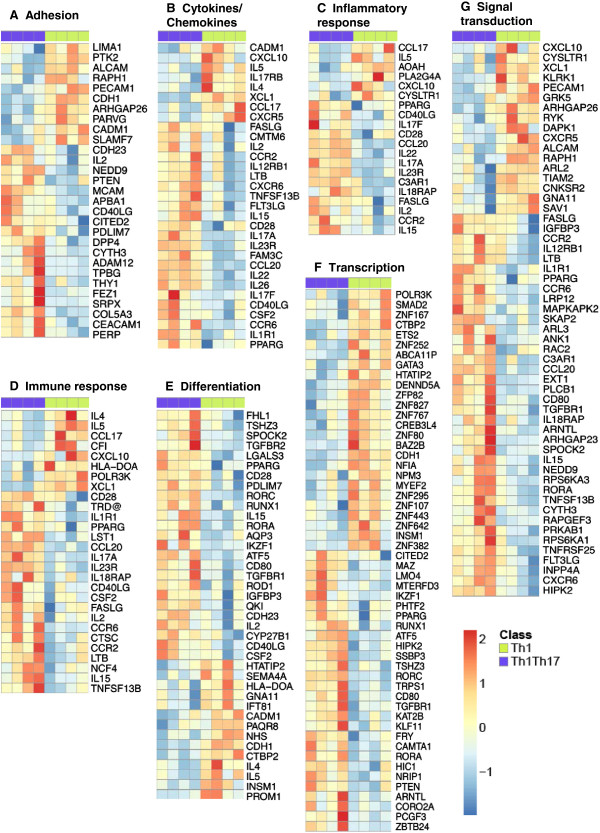
GO classification of differentially expressed genes in Th1Th17 vs. Th1 cells. Differentially expressed genes (p < 0.05, FC cut off 1.3) in Th1Th17 vs. Th1 were classified based on their biological functions using GO as follows: Adhesion (A), Cytokines/Chemokines (B), Inflammatory responses (C), Immune responses (D), Differentiation (E), Transcription (F), and Signal transduction (G). The corresponding heat maps were generated using the R programming language and the pheatmap and ggplot2 libraries (R Core Team). For each heat map, genes expressed at higher and lower levels in Th1Th17 vs. Th1 are represented in red and blue, respectively. Results correspond to matched Th1Th17 and Th1 subsets described in Figure 2.